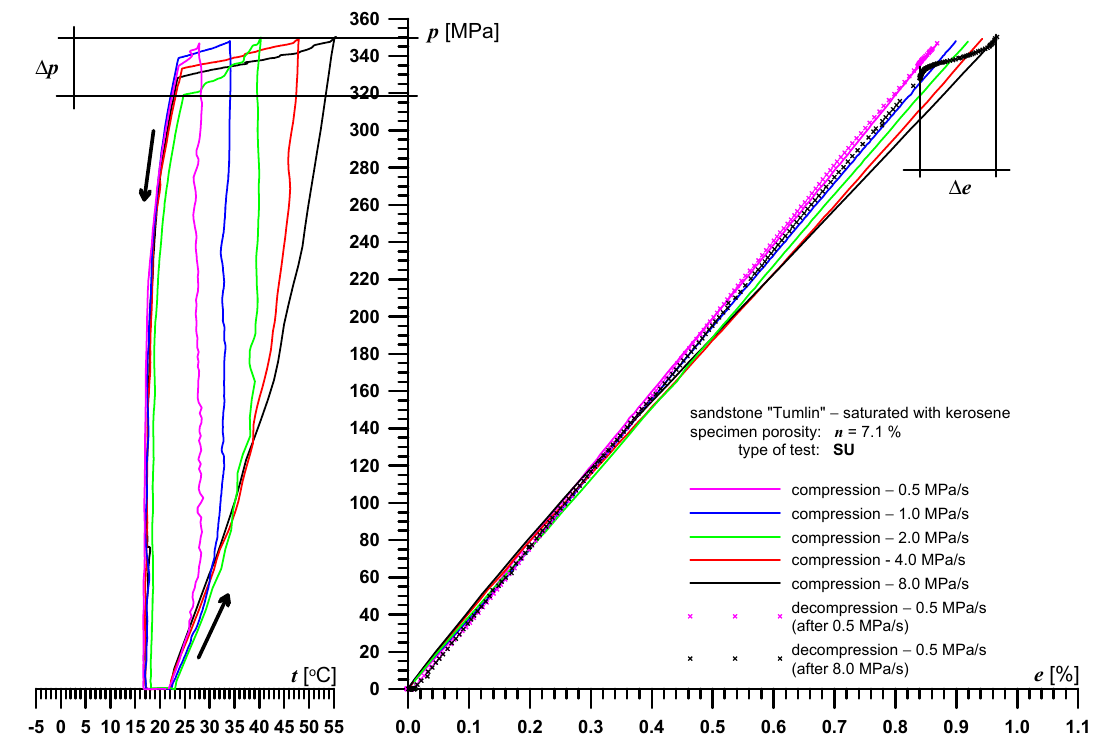
Figure 8. SU test result for Tumlin sandstone. Left : relationship between hydrostatic pressure and temperature (the arrows indicate the direction of change of hydrostatic pressure), right : relationship between hydrostatic pressure and volume change.